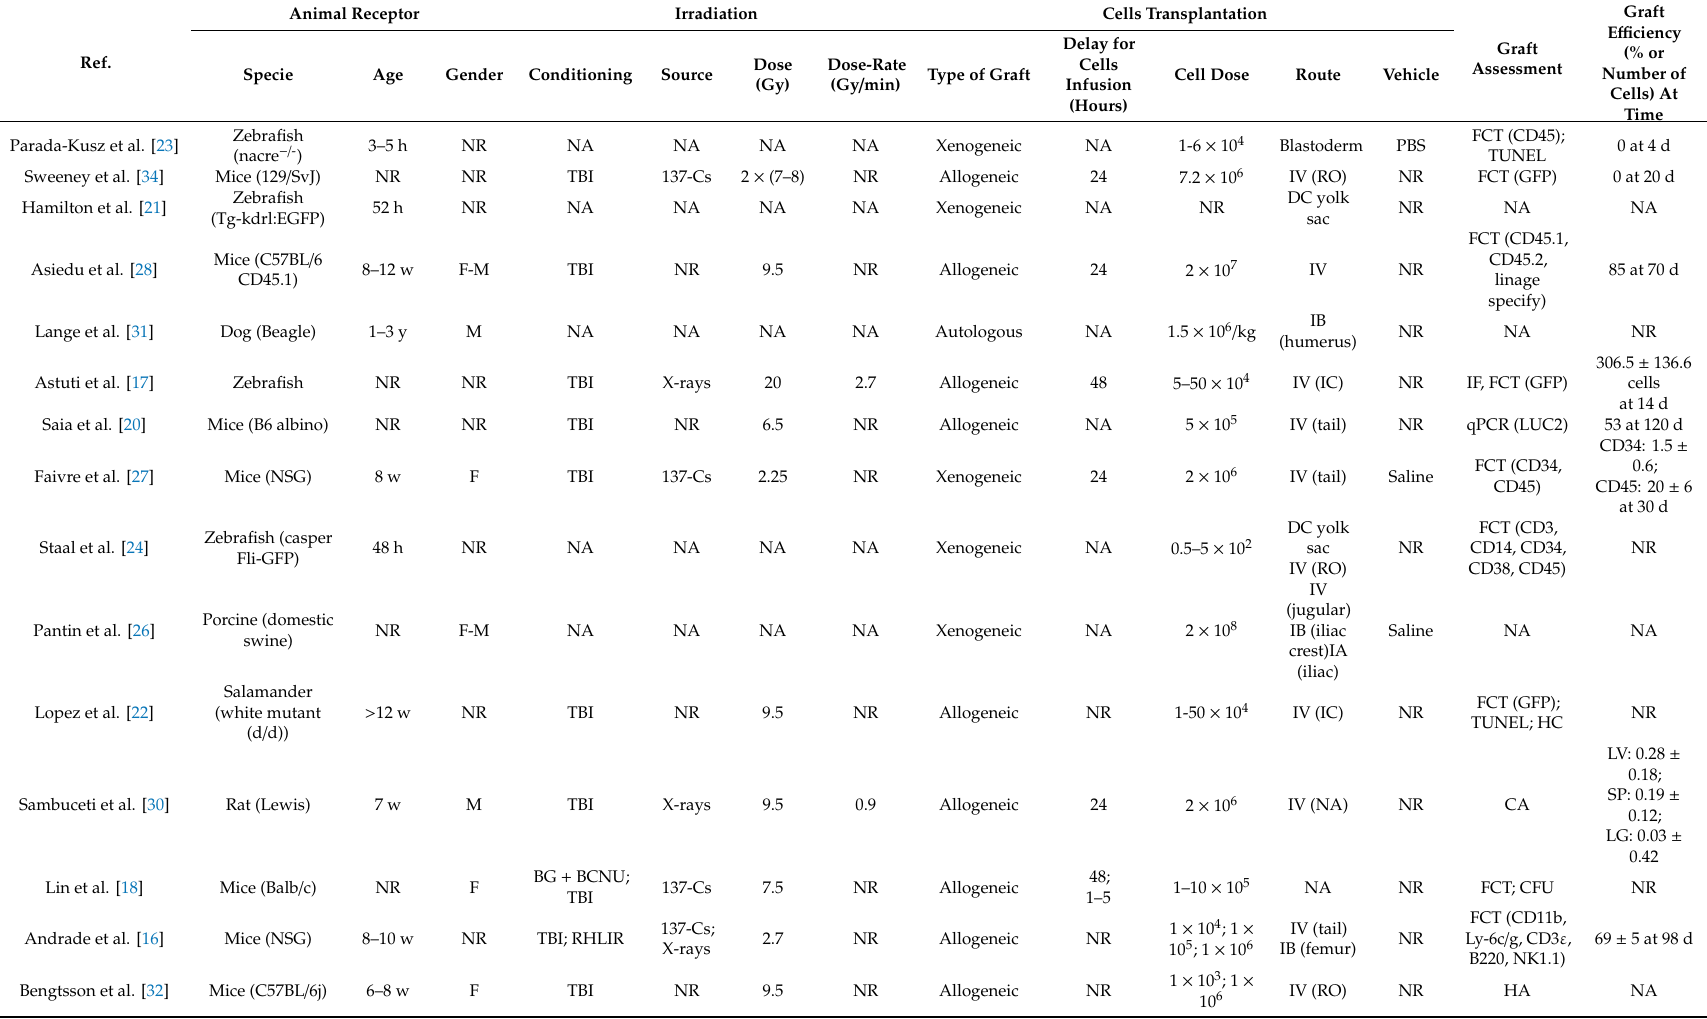
Table 6. Administration of hematopoietic stem cells (HSCs) labeled / transfected in bone marrow transplant